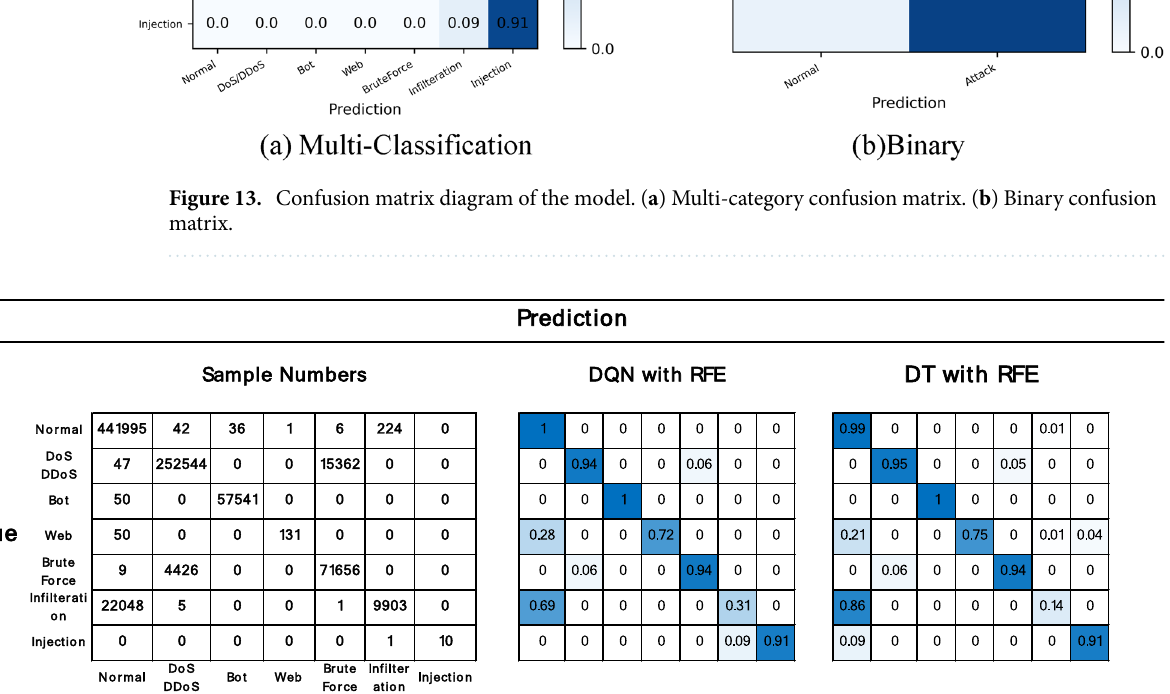
Figure 14. Comparison chart of the two models’ multi-category confusion matrix. The left graph shows the actual number of predictions for each classification. The right plot shows the DQN and DT multi-category confusion matrix,